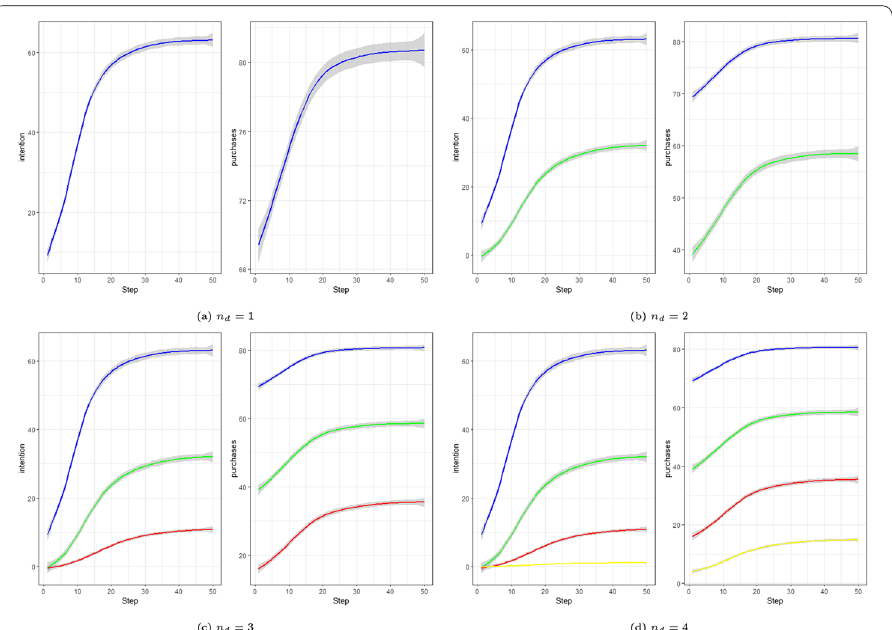
Fig. 2 Evolution of intention and purchase (baseline setup, n d = 1,2,3,4 ), as a percentage of n c . Curves are S‑shaped. Curves’ legend: 1D , 2D , 3D , 4D . The grey shade represents the confidence interval for each curve at 95%